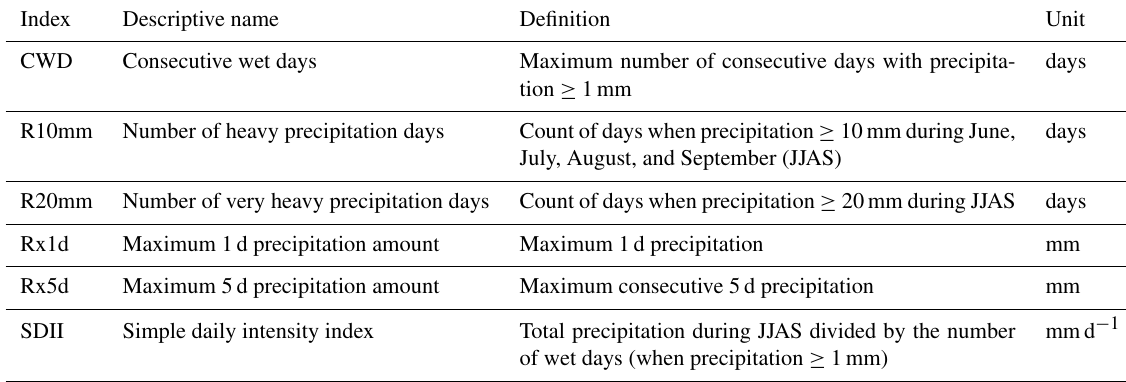
Table 1. Detailed description of extreme precipitation